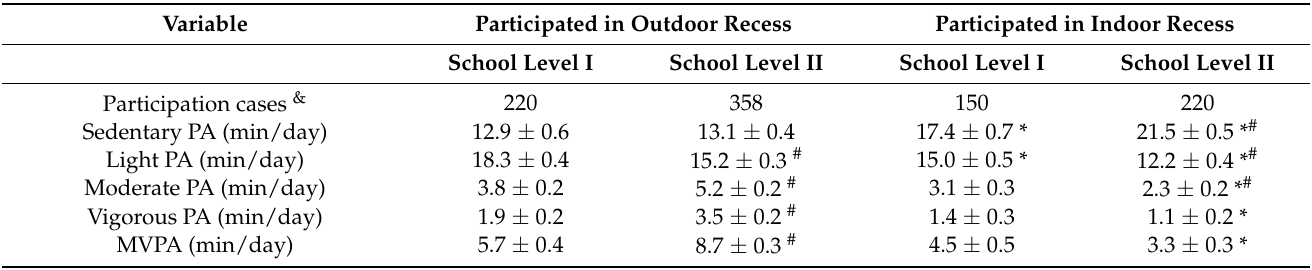
Table 4. Differences in time spent in different activity levels between school levels I and II (mean ± SE) during outdoor/indoor recess.